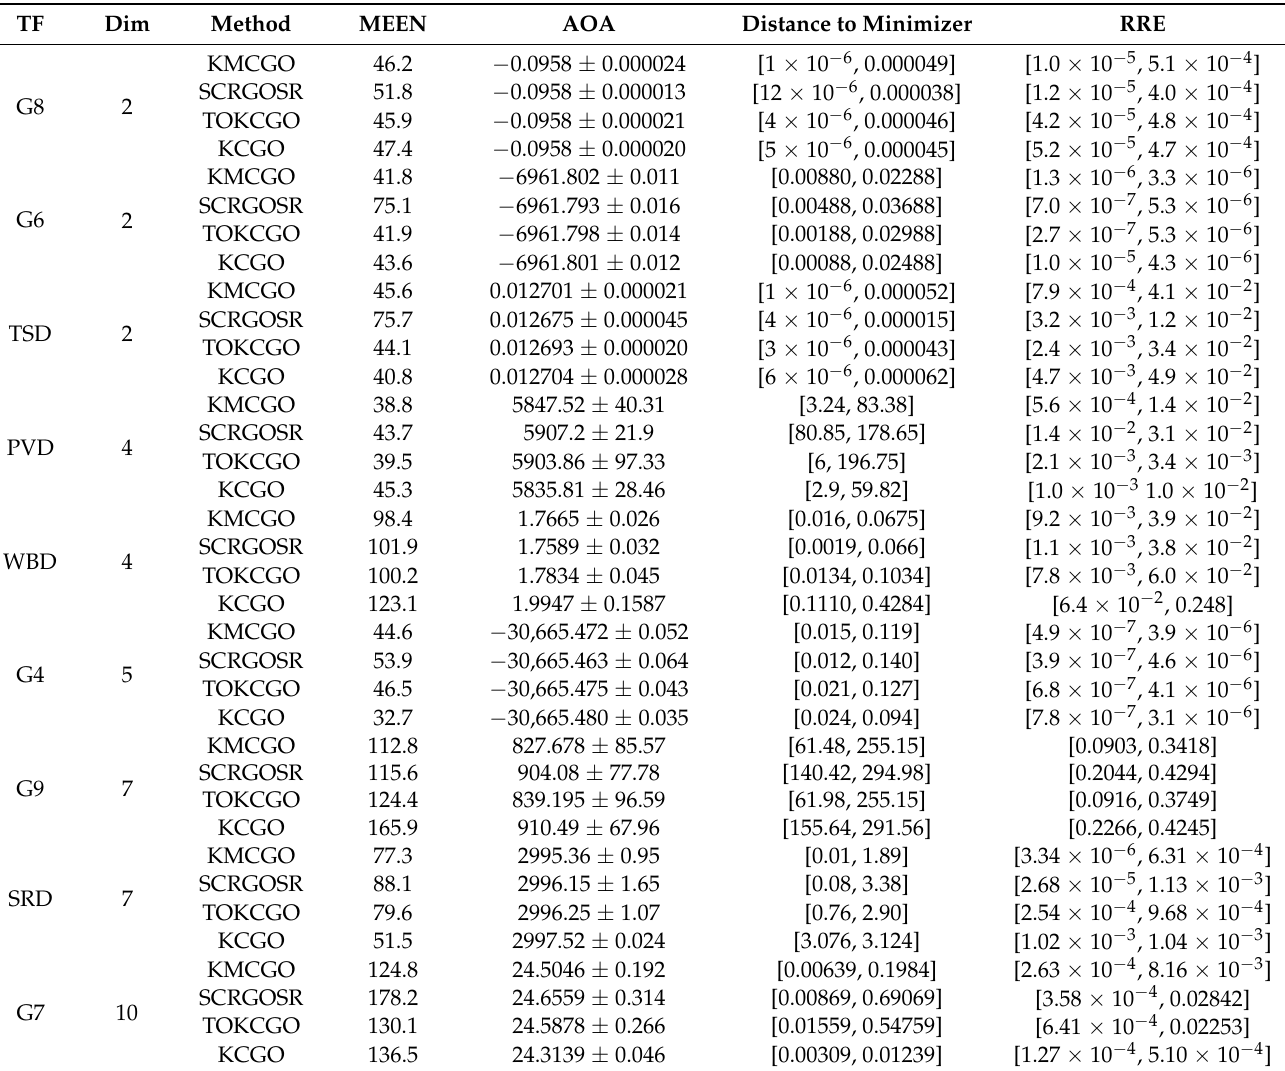
and TOKCGO methods use less mean expensive evaluation number (MEEN) in the TSD and G6 problems, respectively, but their final accuracy and convergence are slightly worse. According to “distance to minimizer” and “RRE,” SCGOSR also shows good convergence in the WBD problem, but it requires a little more MEEN. However, judging from the overall performance, the proposed method shows the best performances. Table 4. Comparison of the KMCGO, SCGOSR, TOKCGO, and KCGO methods. The comparison parameters include MEEN (mean expensive evaluation number), AOA (approximate optimum area), and RRE (real relative error). TF